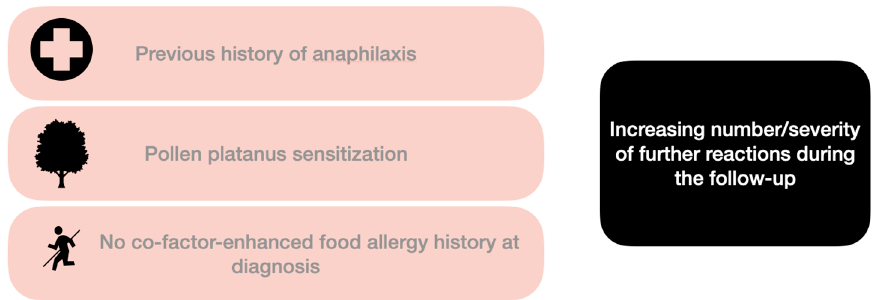
Figure 2. Main associations between clinical factors at the diagnosis and number/severity of further reactions during the follow-up. An association (assessed by Chi-square test) is noted with a previous history of anaphylaxis treated in Emergency Room at T0 ( p = 0.006), absence of co-factor-enhanced at diagnosis ( p = 0.004), platanus pollen sensitization ( p = 0.026).